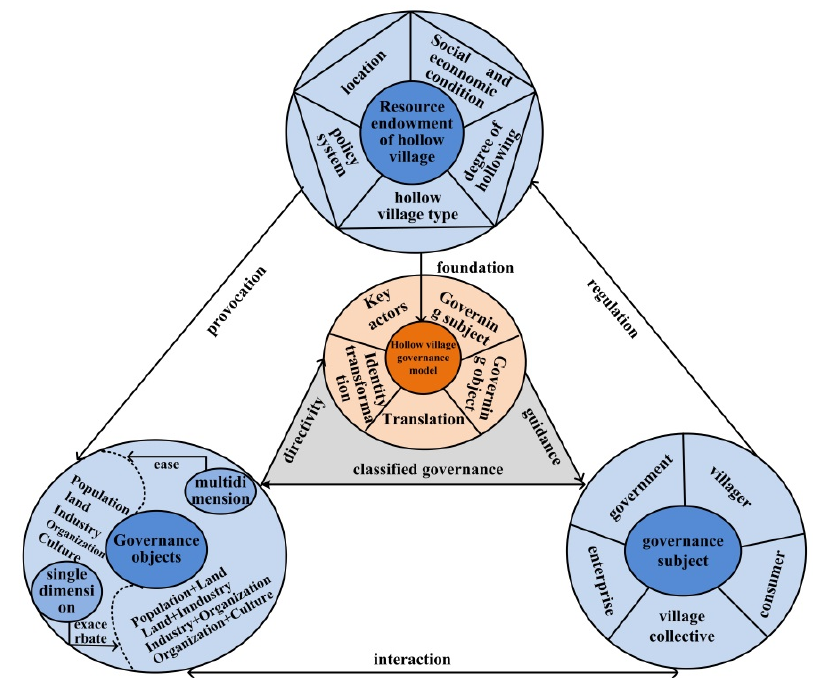
Figure 4. Deconstruction of hollow village governance